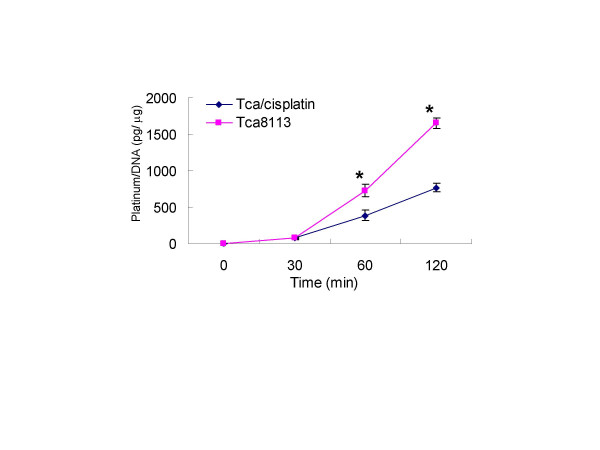
Platinum accumulation on DNA in Tca/cisplatin and Tca8113. DNA was extracted from Tca/cisplatin cells (blue) and Tca8113 cells (pink) after treatment with 200 μM cisplatin for 0, 30, 60 and 120 min. The platinum concentration in isolated DNA was measured by ICP. Each point is the mean of three independent experiments. Significant differences were observed at 60 min (P = 0.008, Student's t test) and 120 min (P = 0.002, Student's t test), which are marked with asterisks.